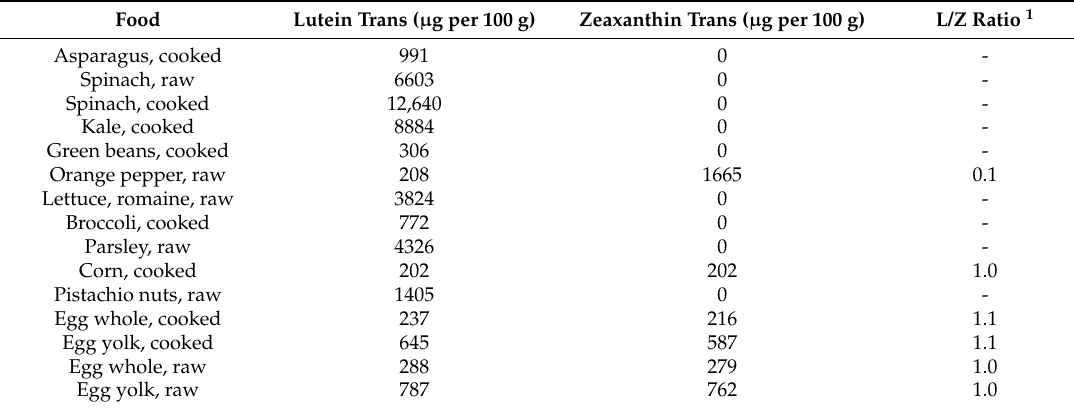
Table 4. Individual lutein and zeaxanthin values of common foods [65].